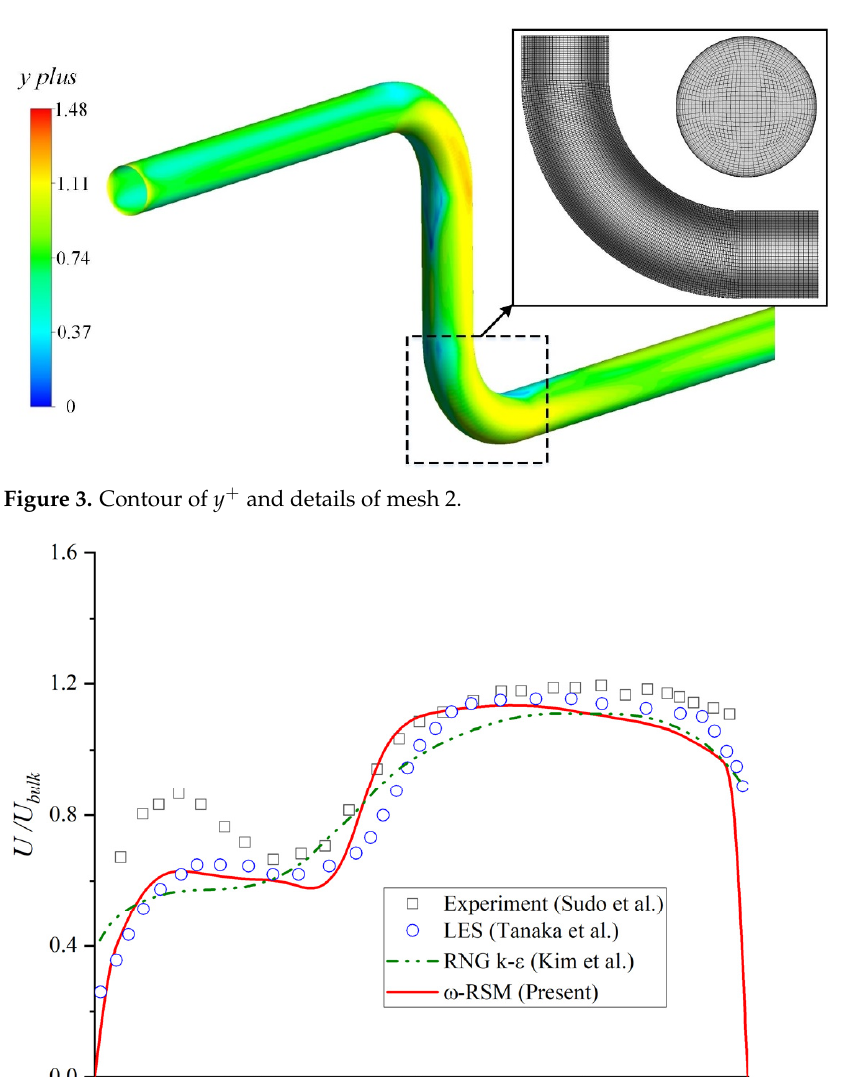
7 of 23 Figure 3. Contour of 𝑦 (cid:2878) and details of mesh 2. Then, a validation study was carried out to confirm the reliability of the numerical